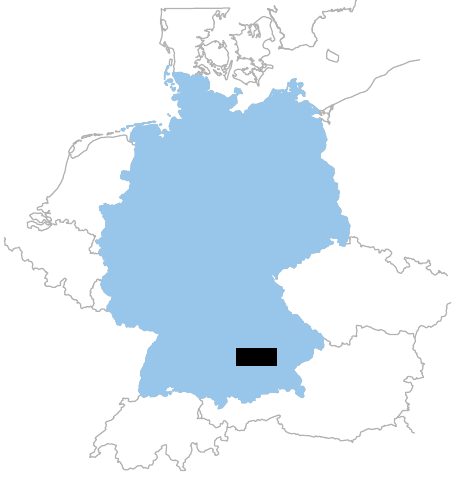
Figure 4. In our experiments, we used an area of interest of 102km 42km (black rectangle) in the north of Munich, × Germany, as study area containing 137k field plots.